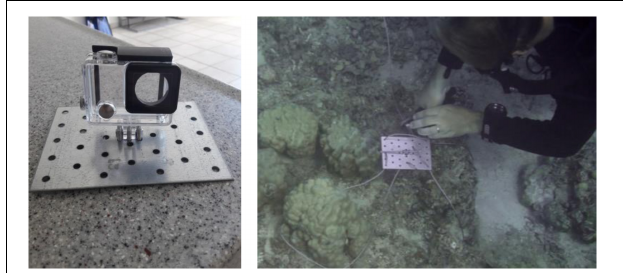
FIGURE 6 | Installation built for the stationary photo sampling (left: metal loops fixed onto a metal plate to interlock the GoPro camera housing; right: mounting process of the metal construction as fixation for the 10-day photo